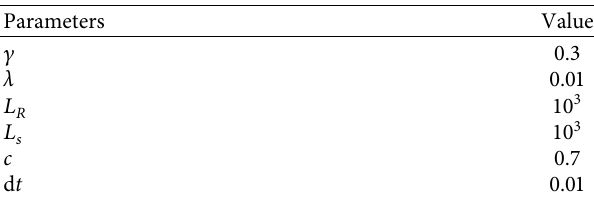
Table 10: Parameters for obtaining K